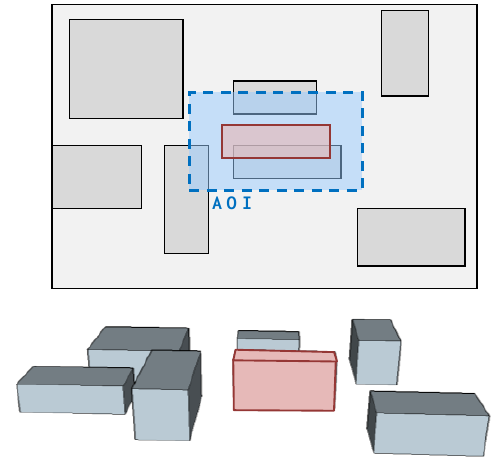
Figure 1. Building model back-projection